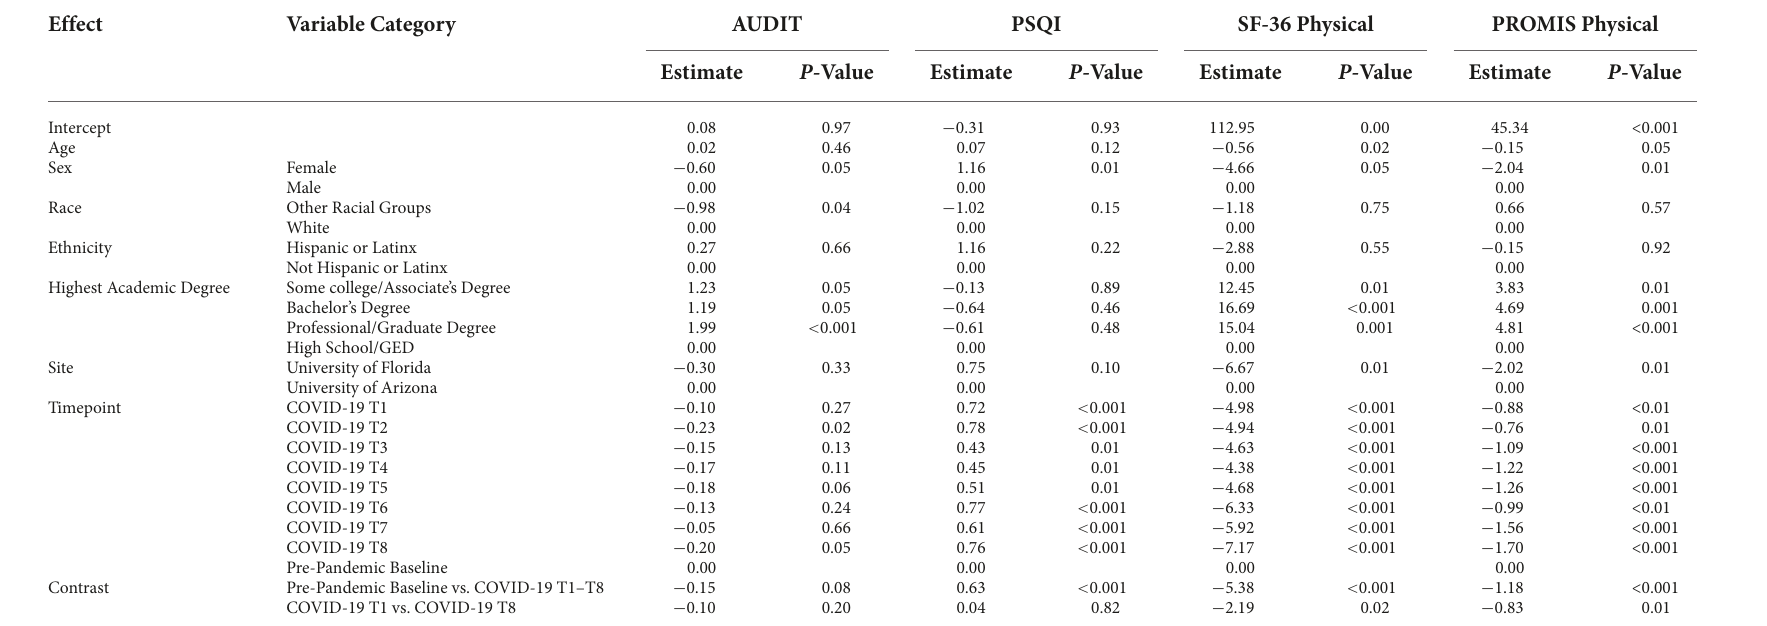
TABLE 3 Health behavior